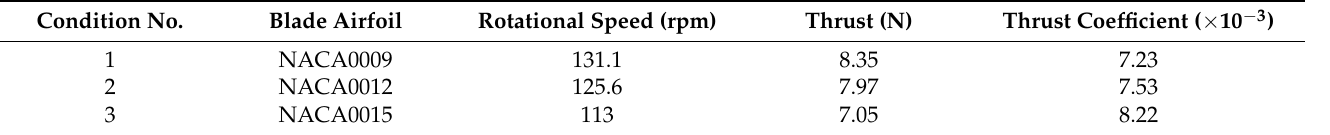
Table 3. The thrust and thrust coefficient with various blade